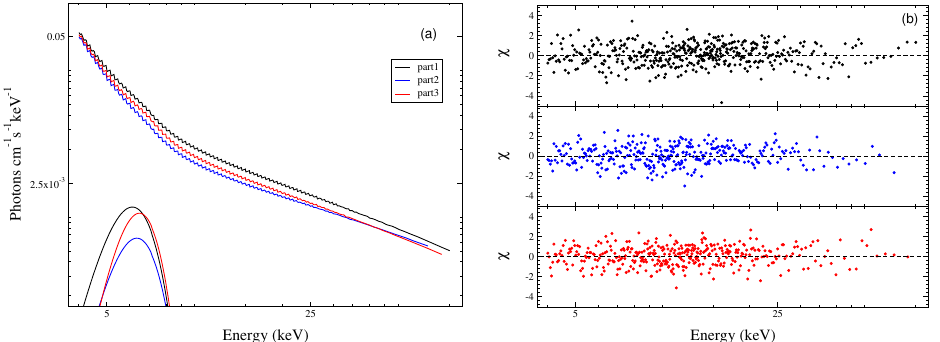
Figure 4. ( a) Best-fitted spectra for the three segments of the NuSTAR observation. The right panel ( b ) shows the χ (i.e., (data − model)/error) variations of the three spectra in respective